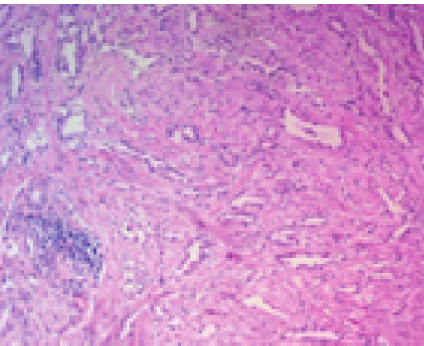
Figure 3: Adenomatoid tumor. Multiple irregular spaces (vacuo- lated cytoplasm) coated by a layer of flat or cuboidal epithelial cells and surrounded by collagenous stroma and muscle fibers (H-E